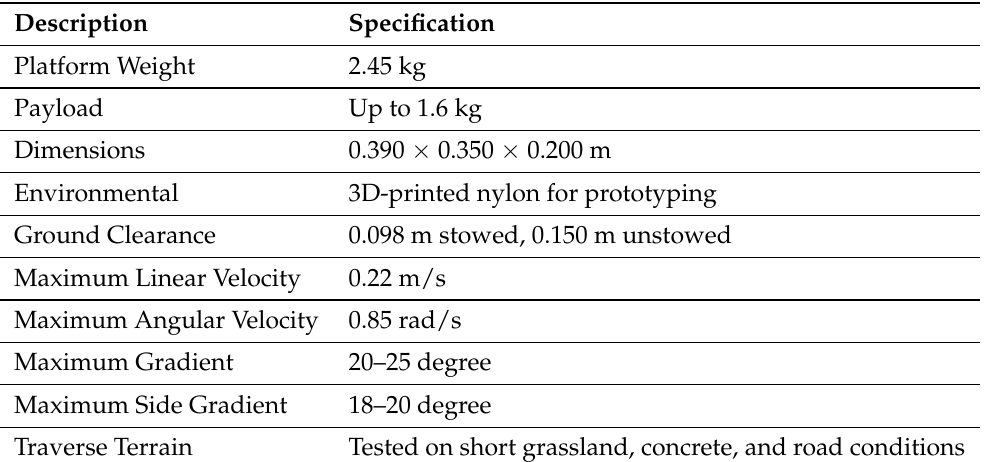
Figure 2. Different views of Raptor. ( a ) Isometric view; ( b ) Front view; ( c ) Side view; ( d ) Top view. Table 1. Technical specification of robot